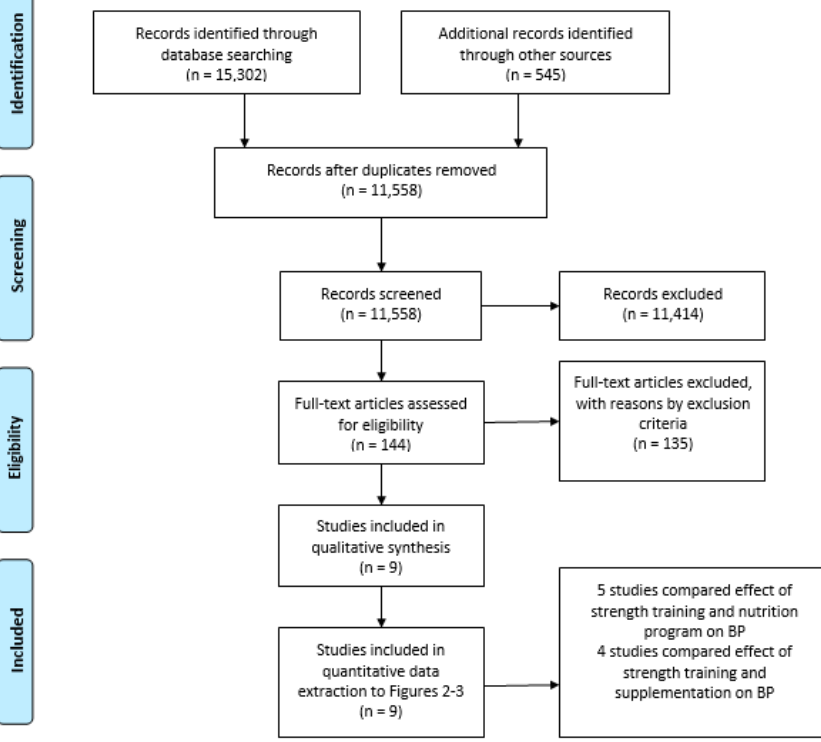
Figure 1. Flowchart of the selection process. BP = blood